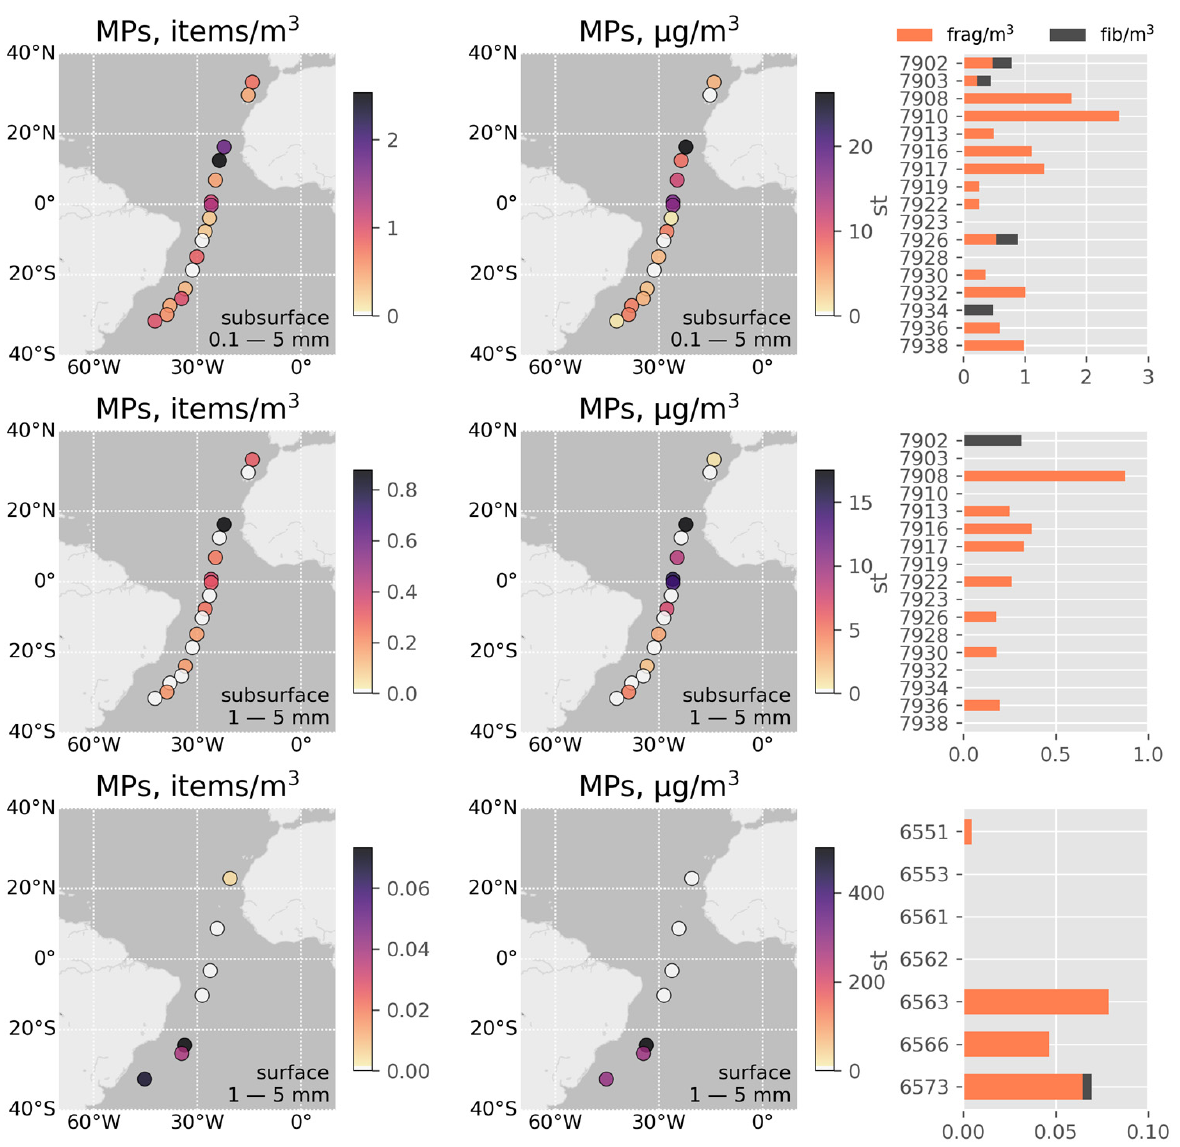
Figure 4. Microplastics concentrations at different stations.